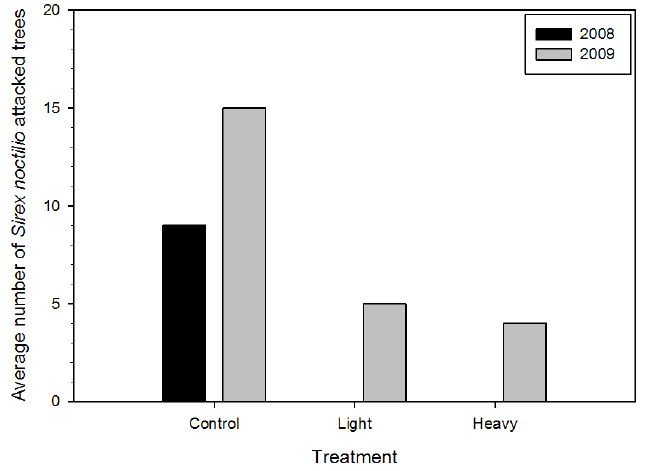
Figure 3. The number of Pinus sylvestris attacked by Sirex noctilio in control and thinning treatments; note that no statistics were conducted on these data because of loss of replicates.